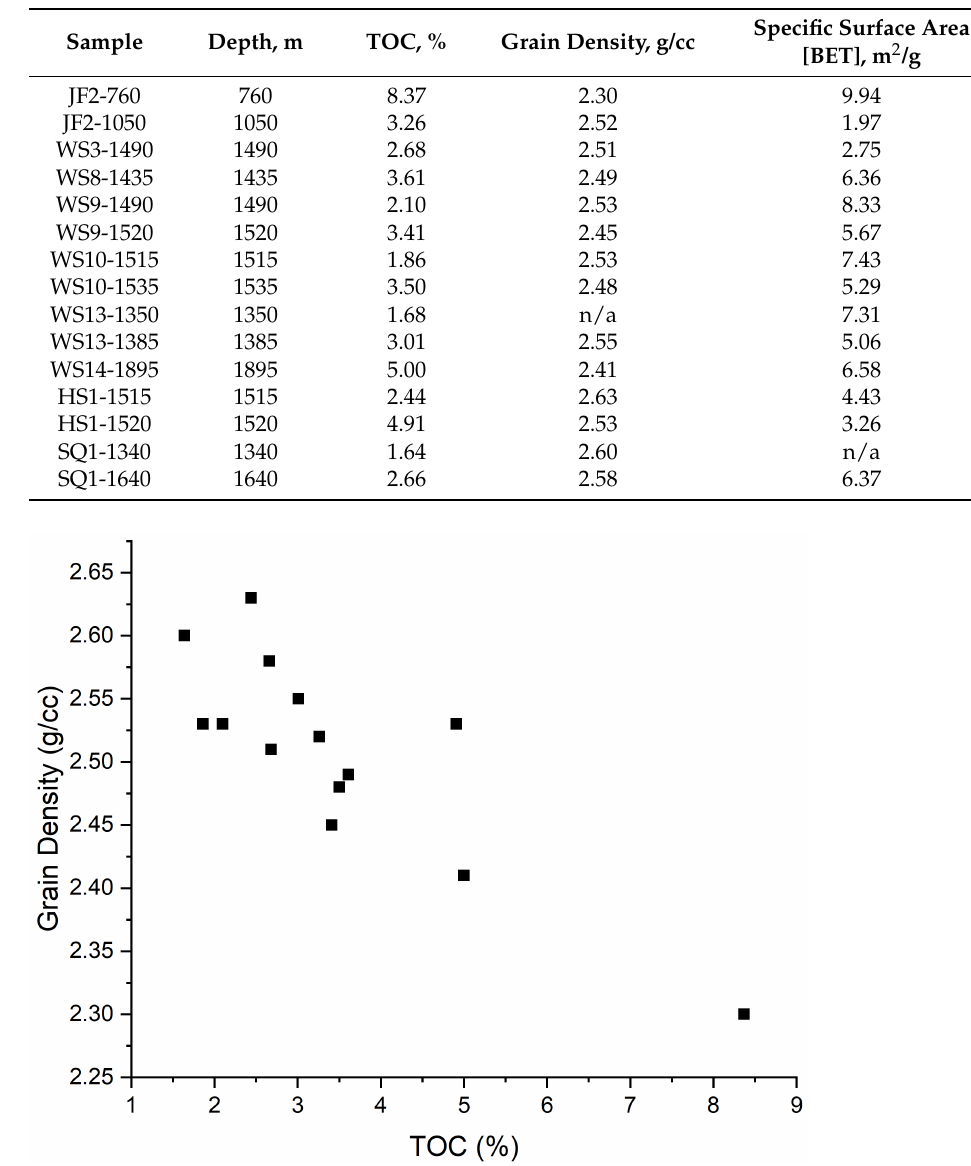
Table 4. TOC, grain density, and specific surface area of examined shale samples.